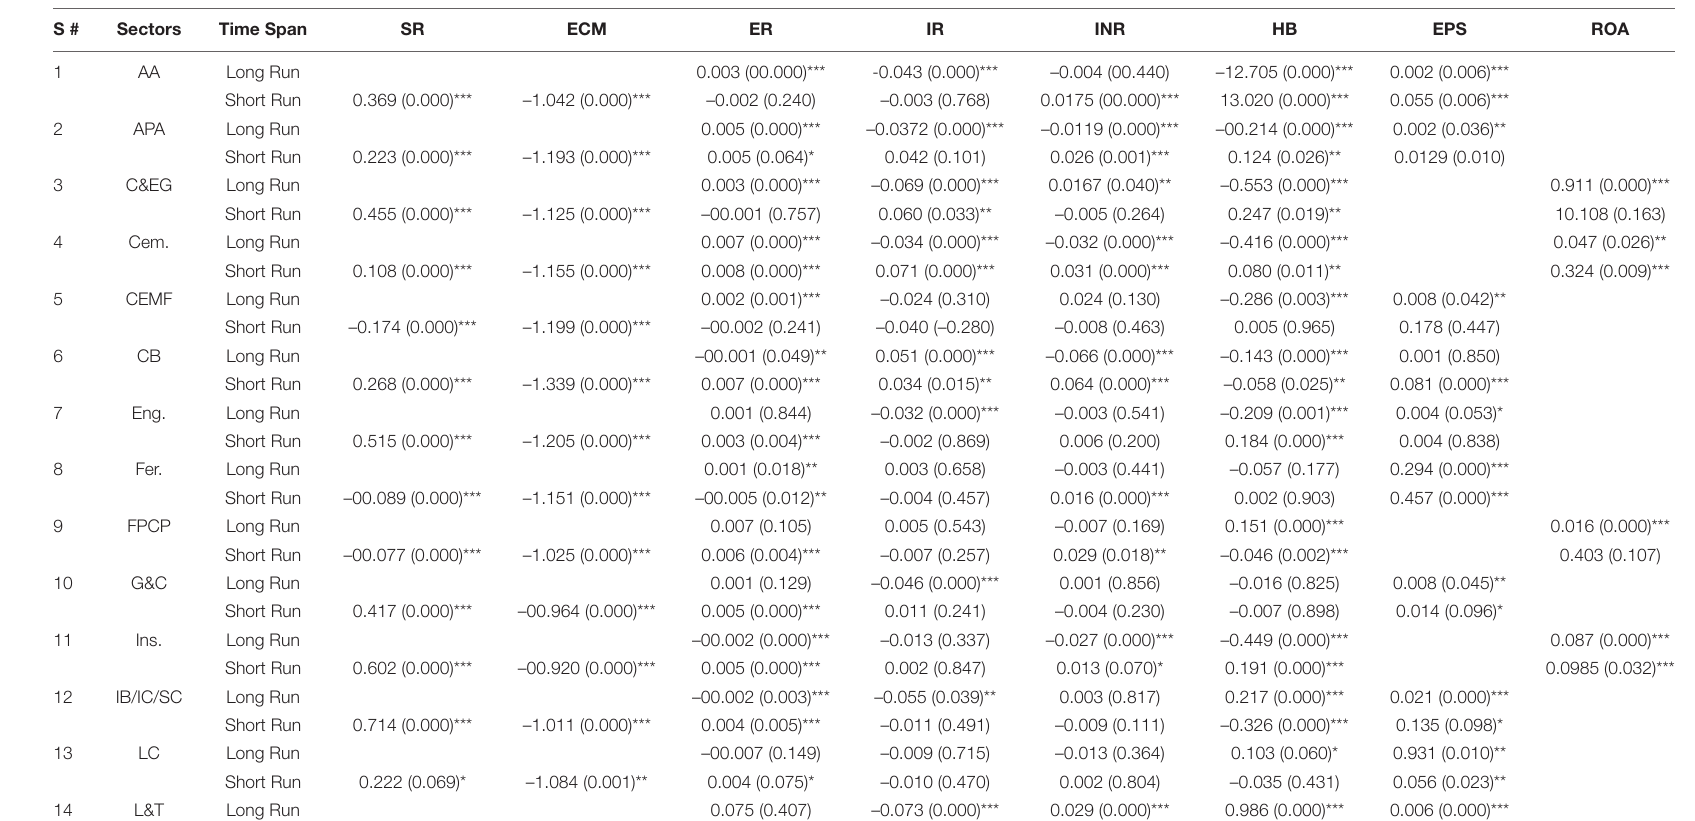
TABLE 4 | Regression results (PMG